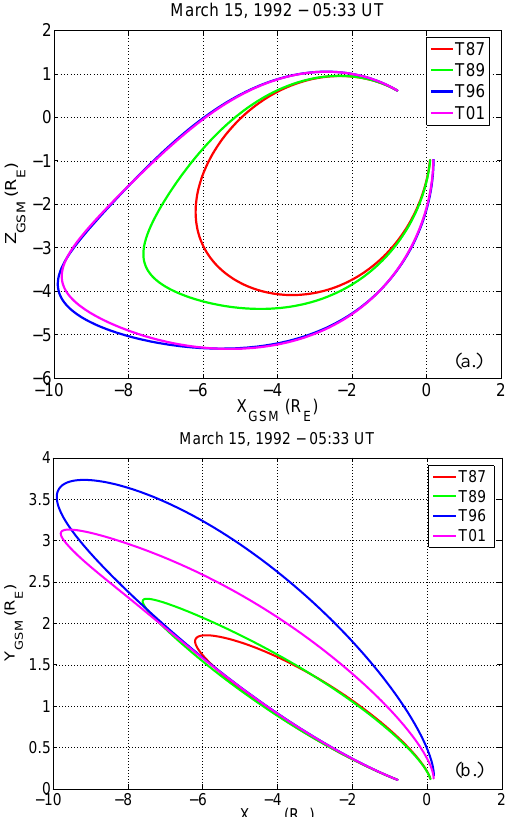
Fig. 3. Meridian plots of the model magnetic field lines mapped from the ionospheric onset location to the magnetotail for the 15 March 1992